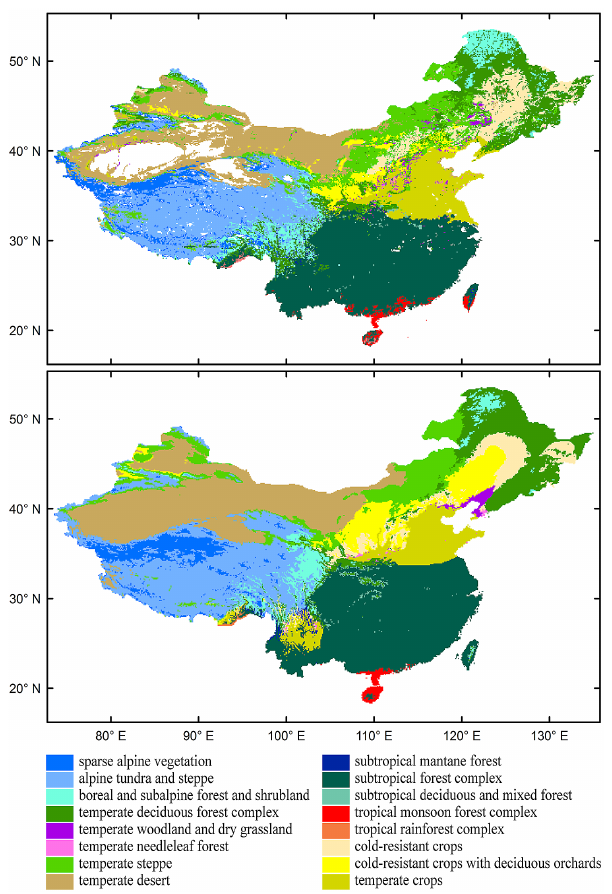
Fig. 1. The observed (upper panel) and predicted (lower panel) veg- etation distribution in China. The plant communities from the Vege- tation Atlas of China at a scale of 1 : 1 million (Hou, 2001) were ag- gregated into 16 vegetation classes based on their bioclimatic con-